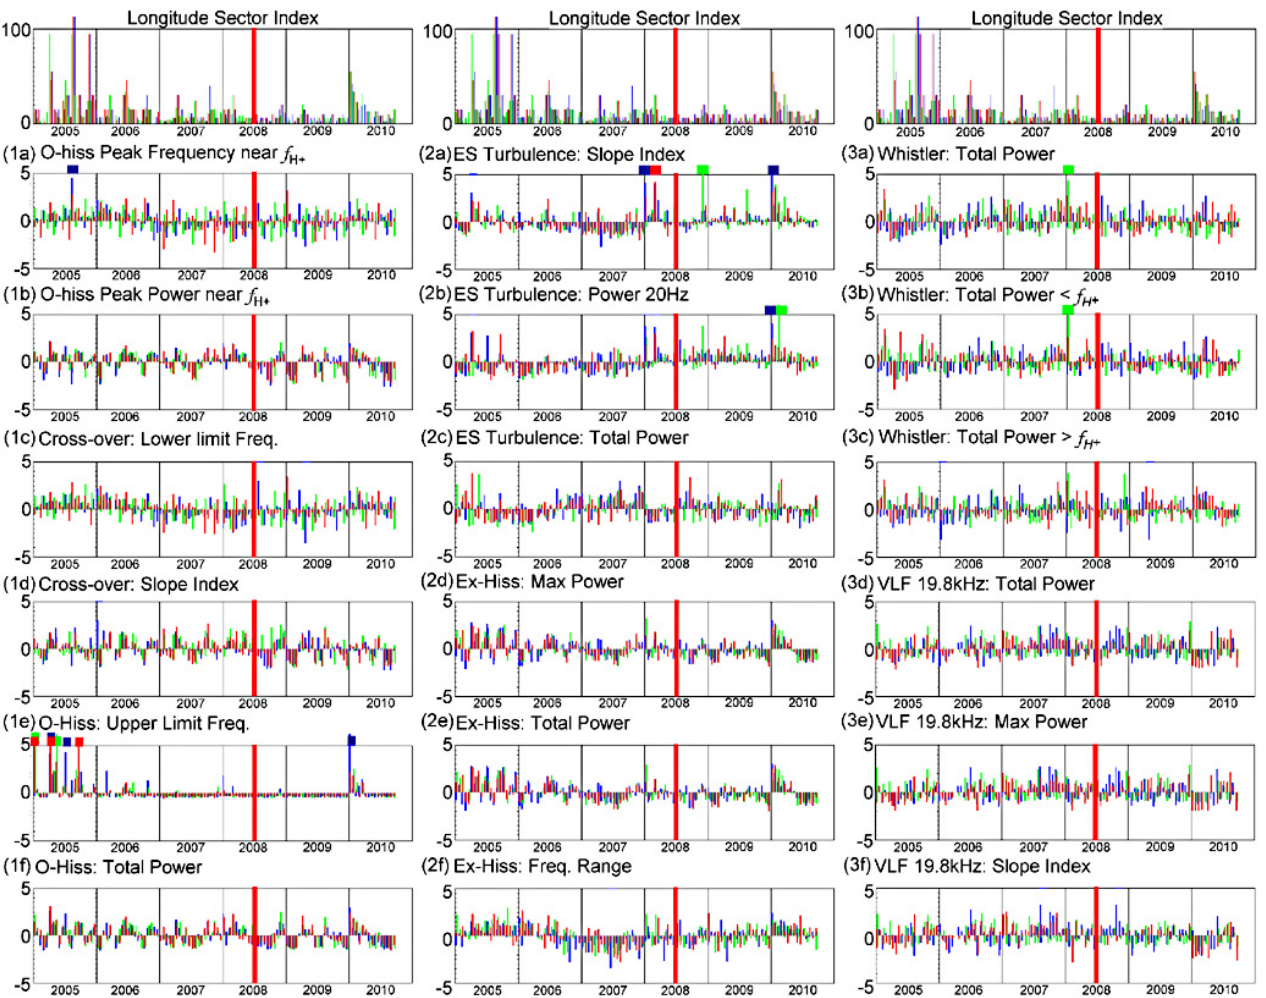
Fig. 4. Orbit average of plasma wave parameters determined from the ICE VLF spectrogram for 6yr, 2005 to 2010, from 3 to 22 May in each year. Data in the western, Sichuan and eastern zones are shown in blue, red and green, respectively. Data are normalized by the standard deviation σ calculated separately for each zone. Large deviations ( > 4 σ ) are indicated by a square symbol of the corresponding colour. The sector index is given in nT at the top of each